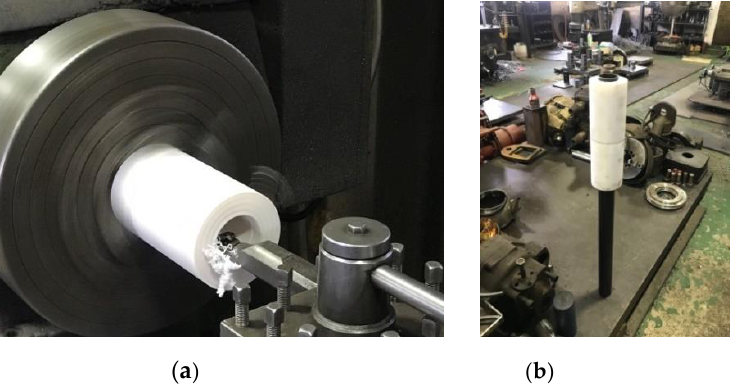
Figure 13. Assembly of bollards with honeycomb and pipes; ( a ) Honeycomb processing; ( b ) Bollard Assembly.